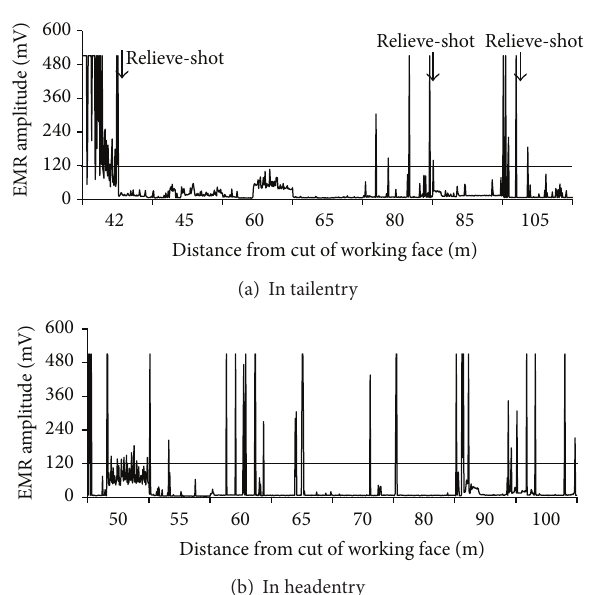
Figure 11: The monitoring result of EMR amplitude at the stage of initial mining.